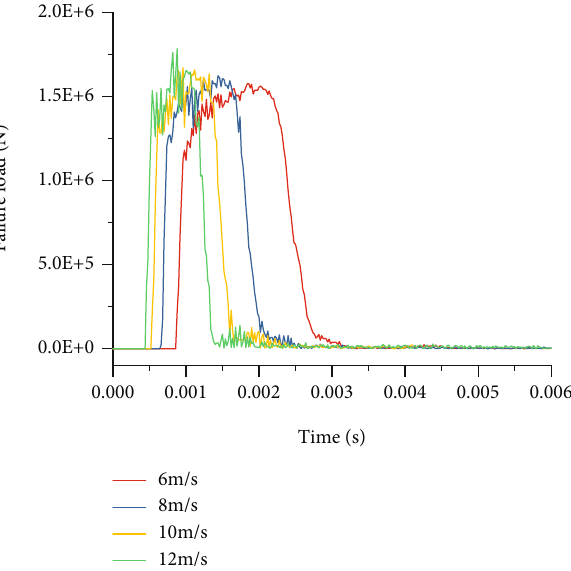
Figure 6: Contact force between shear pins and its connecting